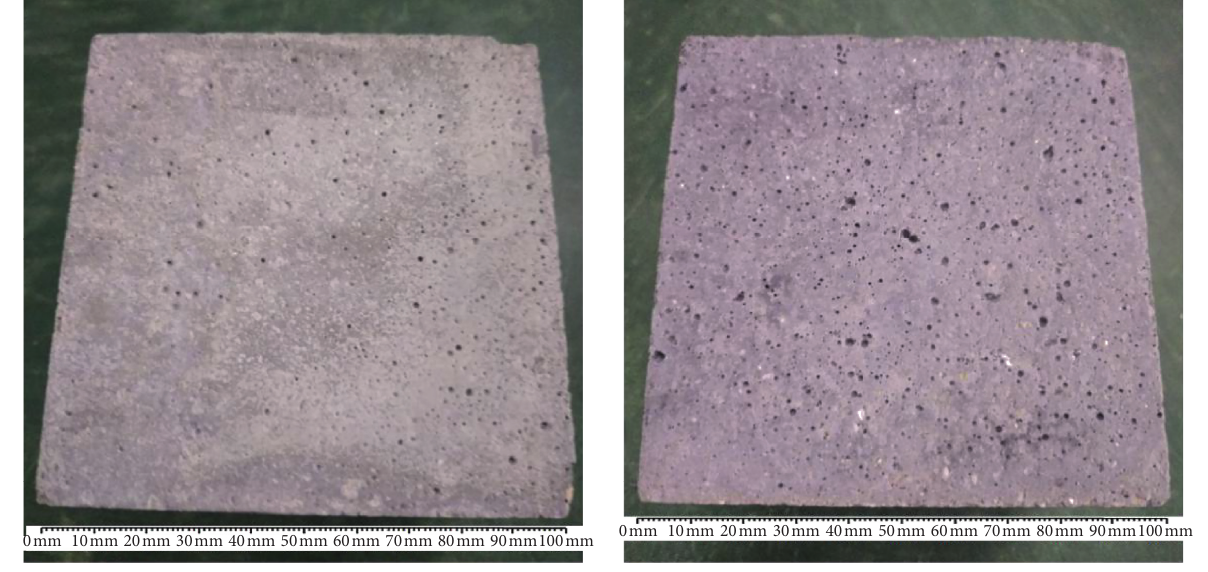
Figure 9: HPC surface after 50 times freeze-thaw cycles. (a) Before; (b)